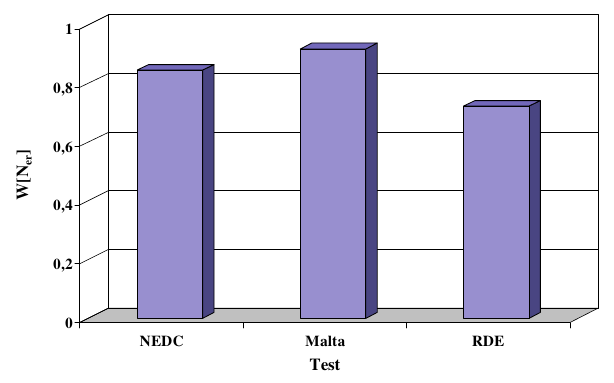
Fig. 15. The relative engine power variation coefficient in the NEDC, Malta and RDE tests